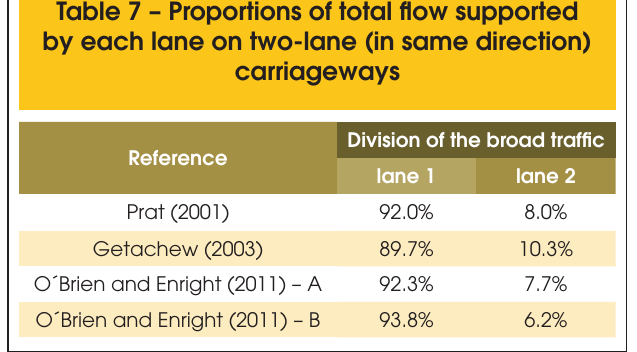
Table 7 – Proportions of total flow supported